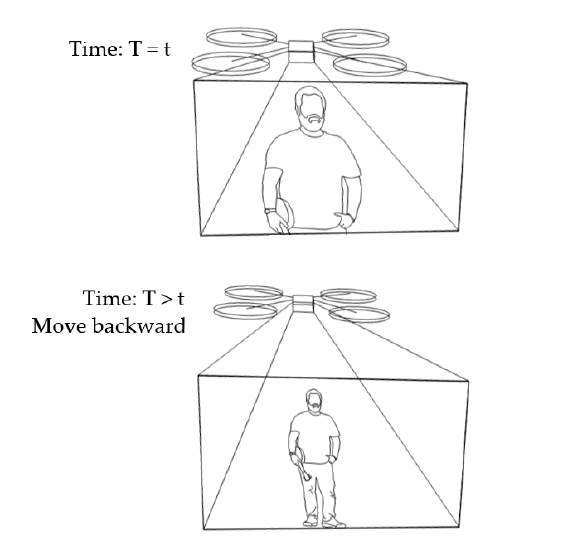
Figure 11. Human motion tracking when the drone moves backward.